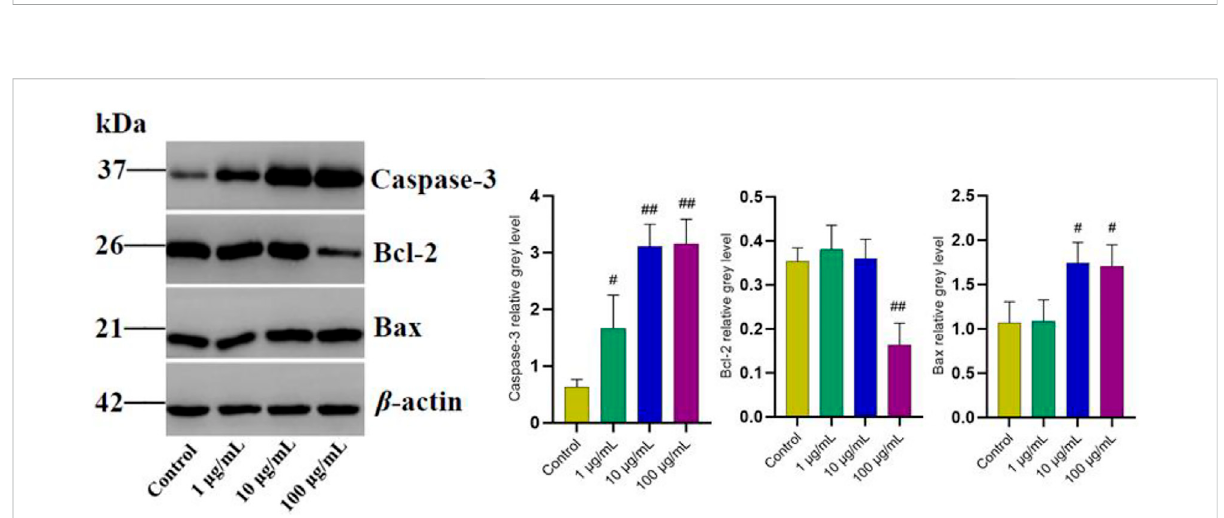
TheeffectsofFTAsonapoptosisofTNF- α -inducedMH7Acells.MH7Acellswereexposedto20 ng/mlTNF- α andintervenedbycorresponding concentrations of FTAs for 24 h, and then the apoptosis of MH7A cells was measured by Annexin V-FITC and PI double staining and fl ow cytometer. The experimental results were recorded as mean ± SD ( n = 3). # p < 0.05, ## p < 0.01 vs. control.